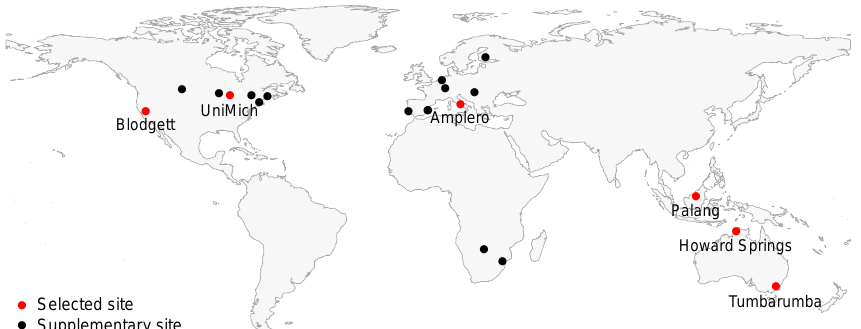
Figure 1. Location of selected and supplementary flux tower